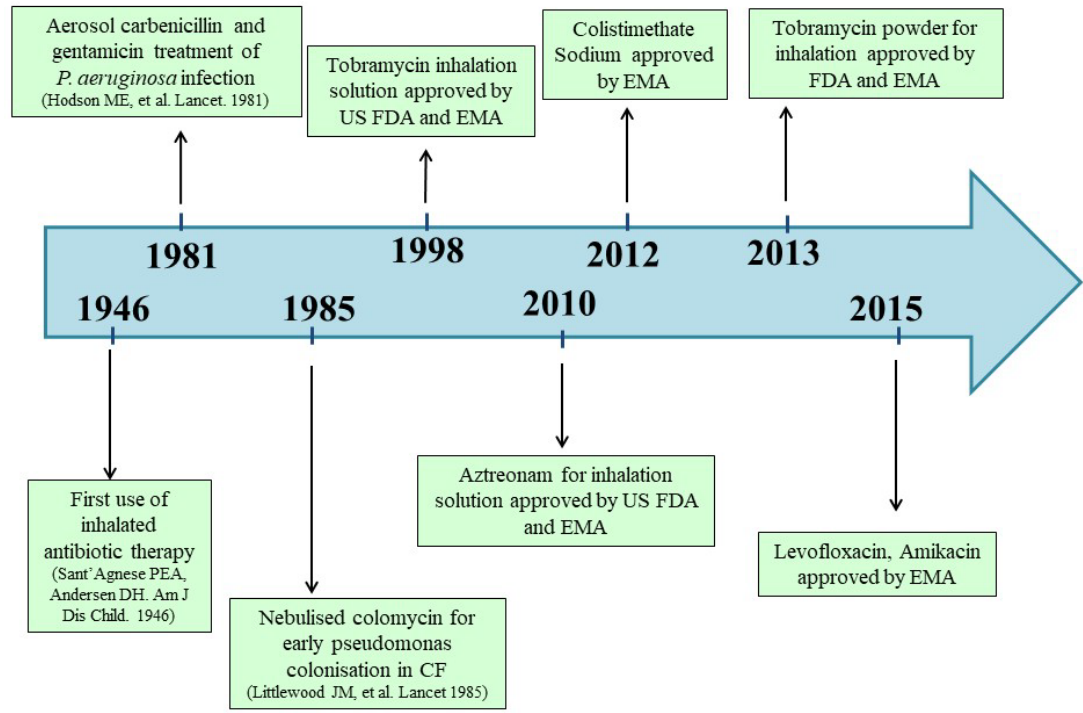
Figure 1. Timetable of the most relevant milestones in the evolution of inhaled antibiotic therapy in cystic fibrosis. Table 1. Aerosolized antibiotics for the treatment of P. aeruginosa infection in CF